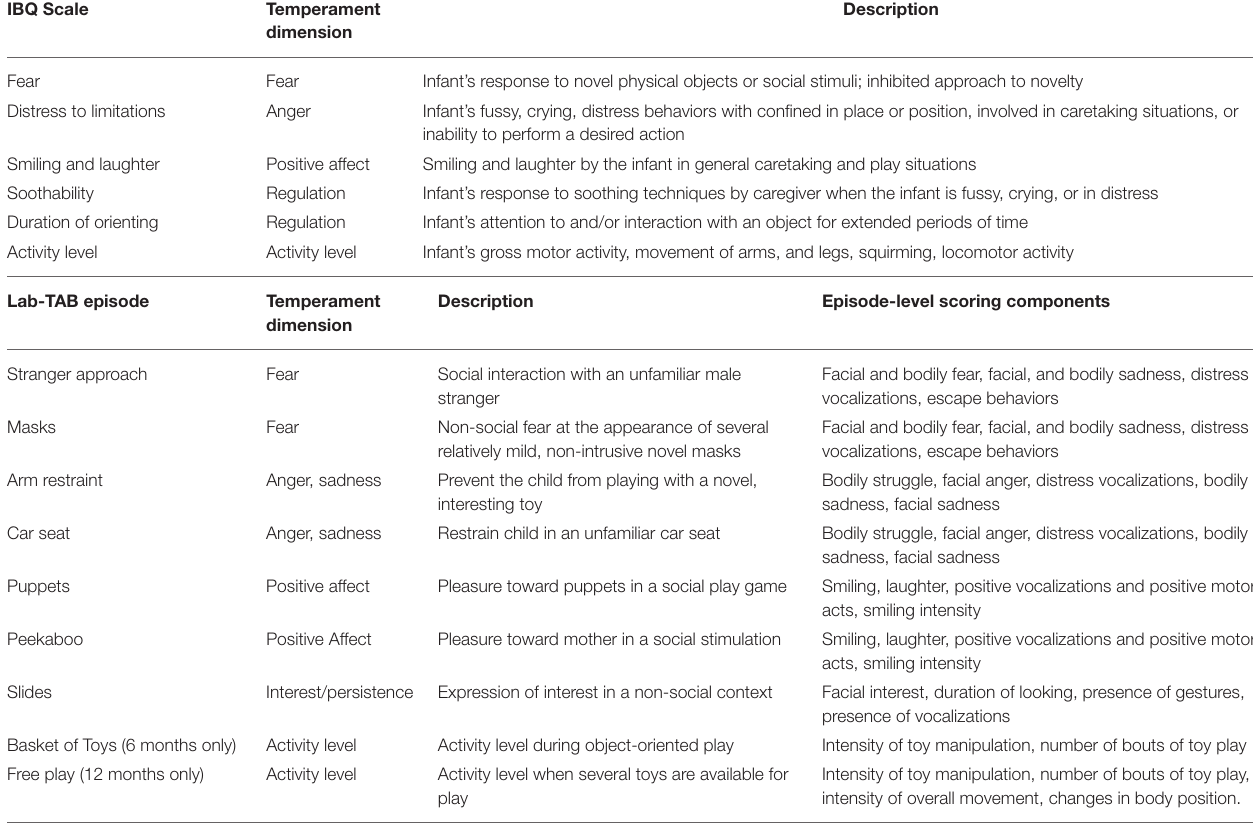
TABLE 1 | IBQ scales and Lab-TAB episode descriptions and scoring components. IBQ